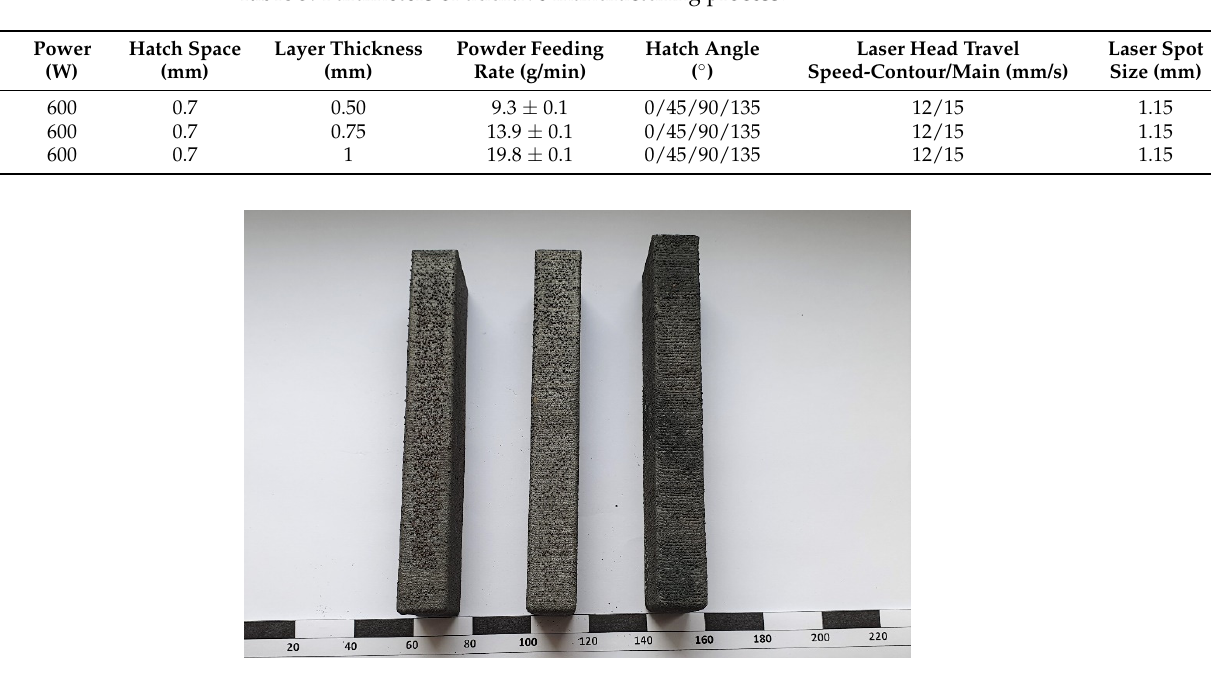
Figure 2. Particle size distribution of the M300 maraging steel powder used for the experiment.